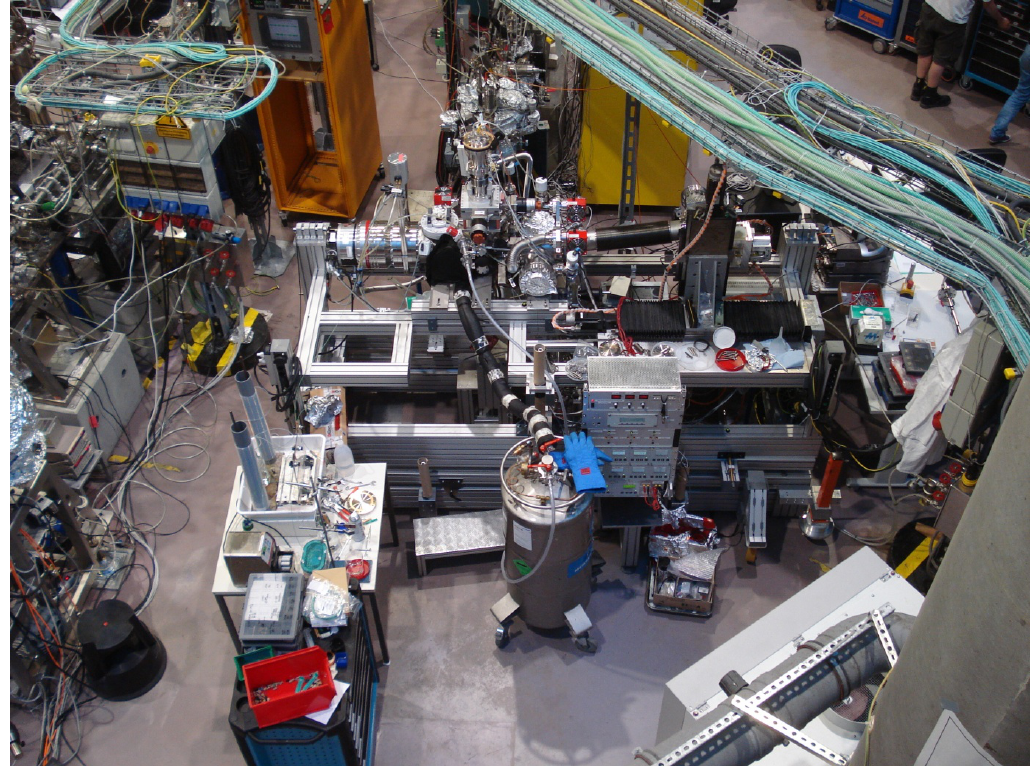
Figure 2: Top view of the LiXEdrom